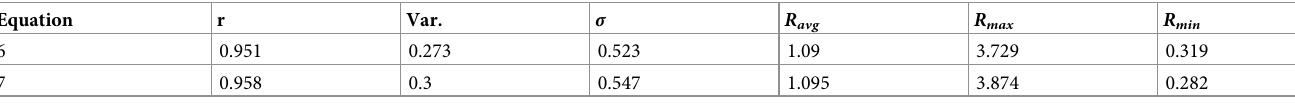
Table 2. Statistical results used in equations